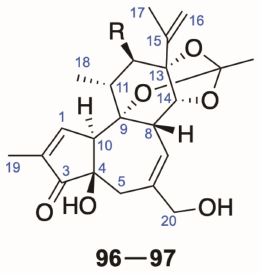
Figure 5. Skeleton of resiniferonoids ( 96 – 97 ).